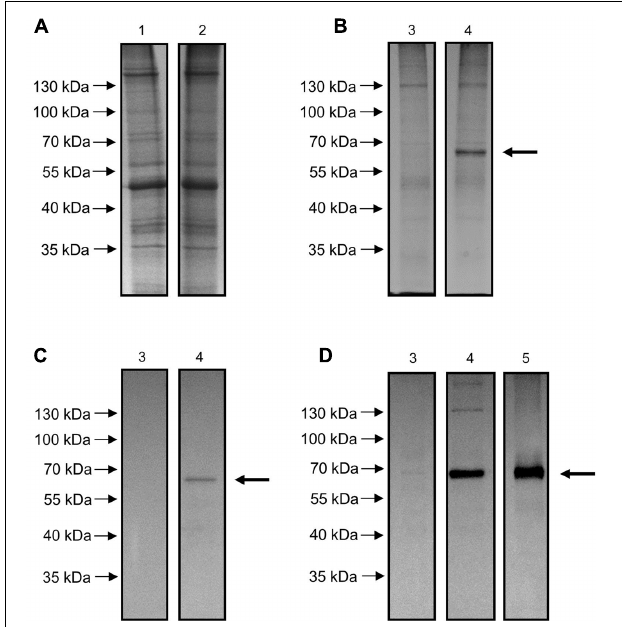
FIGURE 1 | SDS-PAGE of crude extract (A) and purified preparation (B) of N. benthamiana leaves transiently expressing the OepGLU gene and Western blot analysis of purified preparation using anti-6xHis antibody (C) or anti-GLU antibody (D) . Lane 1, crude extract of infiltrated leaves with untransformed A. tumefaciens suspensions (control); lane 2, crude extract of infiltrated leaves with pH2GW7-OepGLU transformed A. tumefaciens suspensions; lane 3, purified preparation of infiltrated leaves with untransformed A. tumefaciens suspensions (control); lane 4, recombinant OepGLU purified preparation; lane 5, purified GLU protein according to the method of Romero-Segura et al. (2009). 6 µ g of protein were loaded per lane in all cases. The primary antibody dilutions used were 1:1500 (C) and 1:5000 (D) and the secondary antibody dilution were 1:2500 (C) and 1:10000 (D) . The band corresponding to the olive β -glucosidase protein is denoted by an